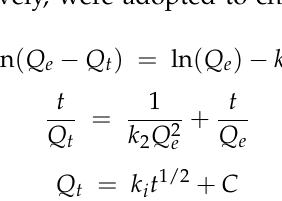
Table 9. Isothermal constants for the adsorption of lead ions on pristine slag. Langmuir Freundlich Dubinin–Radushkevich